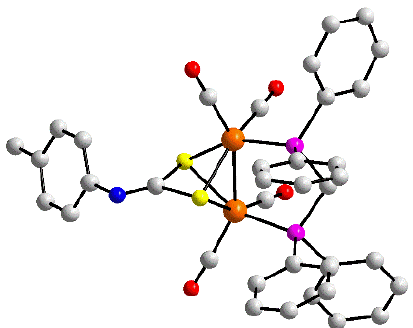
Figure 4. Molecular structure of [(CO) 2 Fe(dppm)Fe(CO) 2 ][S 2 C=N(4-tolyl)] ( 8 ).